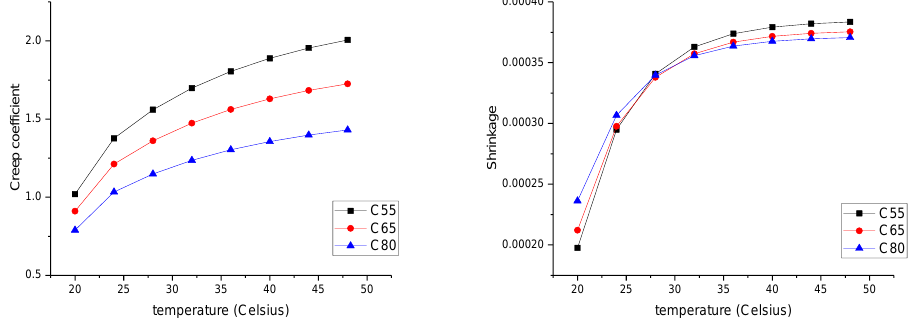
Figure 12. Effect of temperature on the strength of prestressed concrete sleepers.